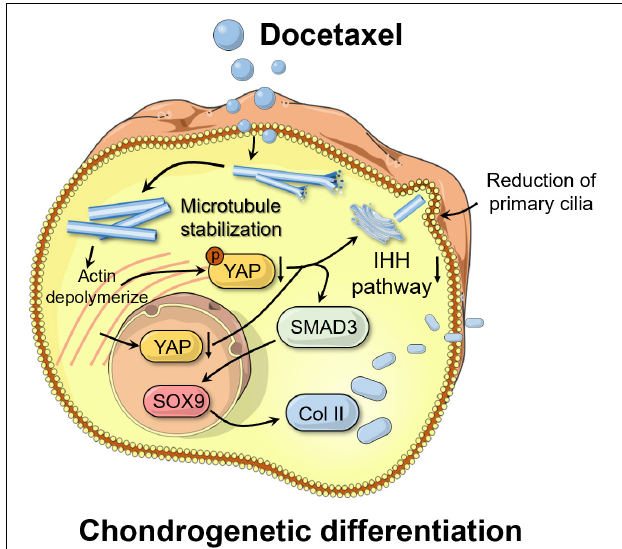
FIGURE 7 | Schematic of the mechanism by which microtubule stabilization potentiates chondrogenic differentiation of synovial mesenchymal stem cells. By inhibiting Yes-associated protein (YAP) expression and activity, stabilized microtubule (MT) activated the chondrogenesis. MT stabilization repressed primary cilia formation, inhibited the Indian hedgehog (IHH) signal, and promoted chondrogenic differentiation of